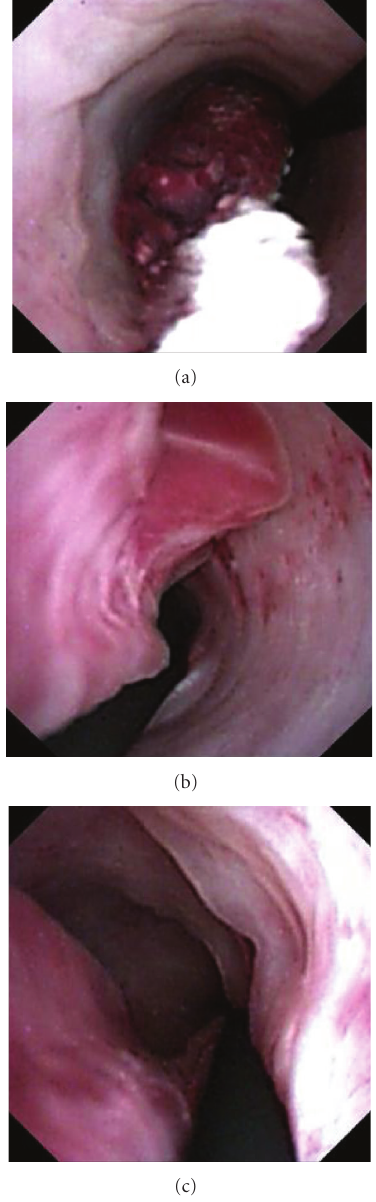
Figure 2: Ureteropyelography presenting a 5cm long tumor in the right mid ureter (distal-mid-proximal part); inlaying guide